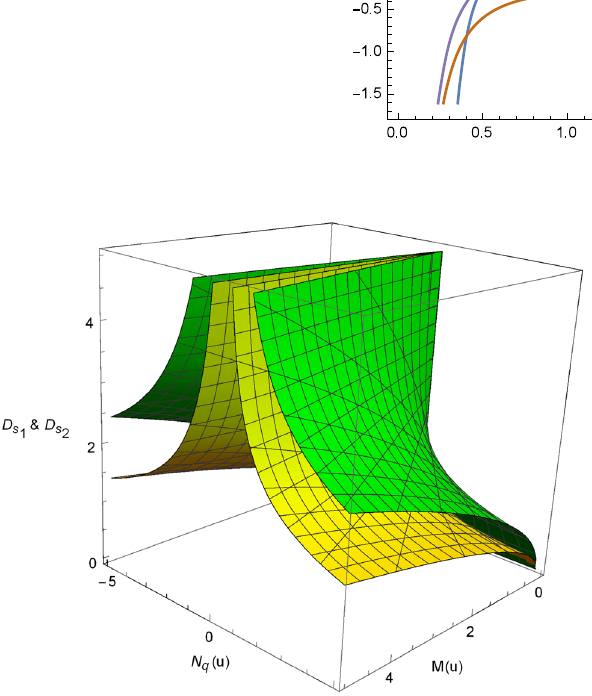
Fig. 12 The variation of D s typical values of the M ( u ) and N r ( u ) parameters for the quintessence